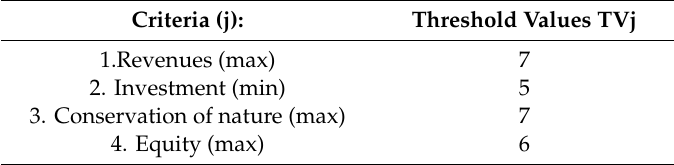
Table 4. Threshold values for each one of the examined criteria of land use